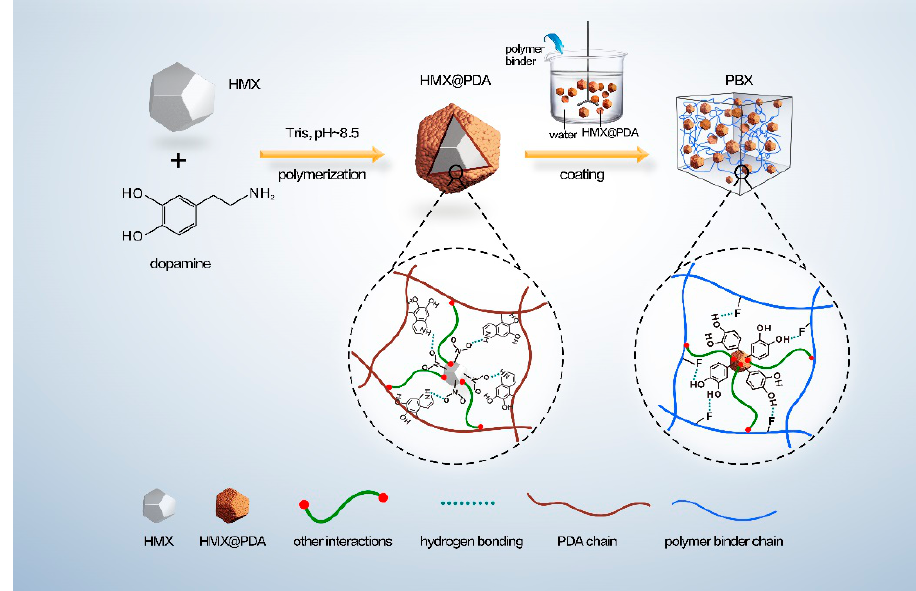
Figure 1. Proposed schematic preparation procedure and enhancement mechanism for polydopamine (PDA) modified polymer bonded explosives (PBXs).